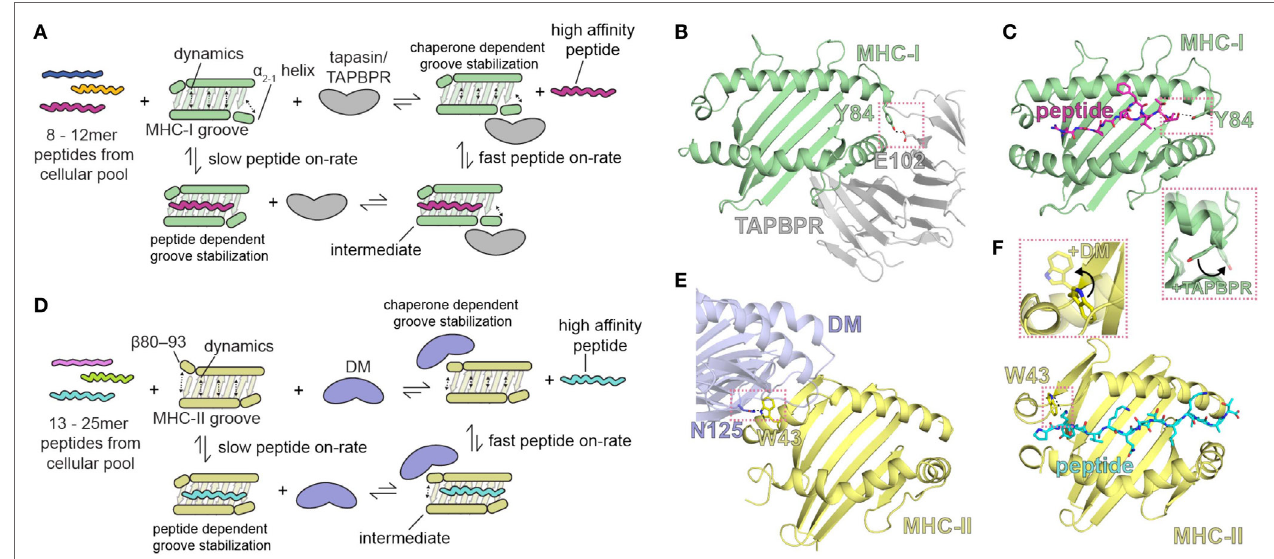
FiGURe 2 | Summary of the role of major histocompatibility complex (MHC) groove structure and dynamics during peptide exchange and editing by the molecular chaperones tapasin or TAP-binding protein, related (TAPBPR). Schematic for class I (A) and class II (D) chaperone-assisted peptide exchange. Peptide exchange/ editing occurs when peptides of 8–12 (class I) or 13–25 (class II) length are selected from the cellular pool in a manner highly dependent on the peptide sequence and the particular MHC allelomorph. This occurs either intrinsically (left) or is mediated by molecular chaperones (right) that increase the kinetic on-rate of peptides binding to the MHC groove through a stable intermediate complex. Conformational dynamics in localized regions of the MHC groove are stabilized by both the peptide and by molecular chaperones. The localized, dynamic regions including the α 2-1 helix of MHC class I (MHC-I) and the β 80-93 helix of MHC class II (MHC-II). (B,e) Structure of chaperone-bound MHC molecules with a focus on the MHC groove. Salmon dotted boxes highlight the conserved residues that are involved in chaperone-induced widening of the MHC groove (DM α N125 and MHC-II α W43; TAPBPR E102 and MHC-I Y84) relative to the peptide-bound state. (C,F) Structure of the peptide-bound (unchaperoned) MHC groove. Salmon dotted boxes highlight “flipping” of MHC-I Y84 and MHC-II W43 upon chaperone association, which in the absence of chaperones associate with the termini of the peptide. The chaperone-bound MHC states are shown as transparent in the inlays. PDB IDs are 5WER (H2-D d /TAPBPR), 3ECB (P18/H2-D d ), 4FQX (HLA-DM/HLA-DR1), and 1DLH (Flu